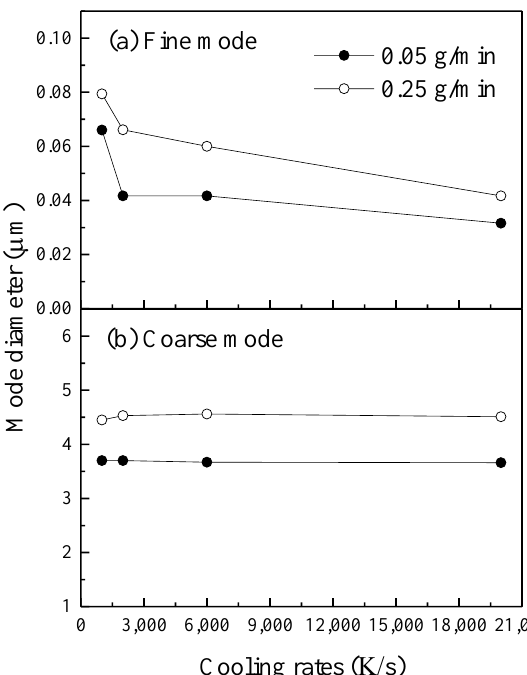
Figure 6. The calculated peak diameter varies with cooling rate at two biomass feeding rates. ( a ) Fine modal diameter and ( b ) coarse modal